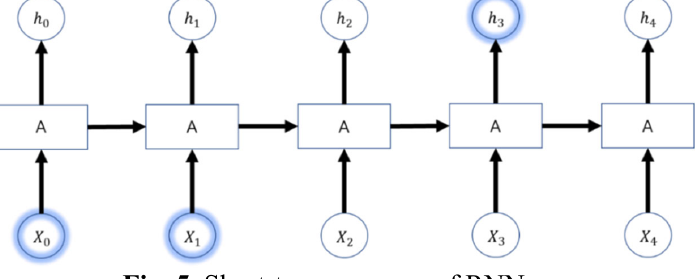
Fig. 5. Short-term memory of RNN